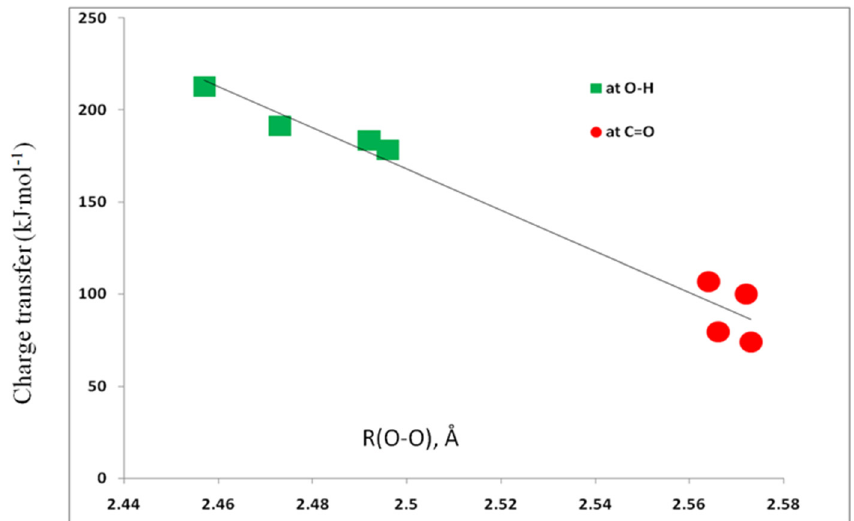
Figure 5. Charge-transfer energies versus the O–O